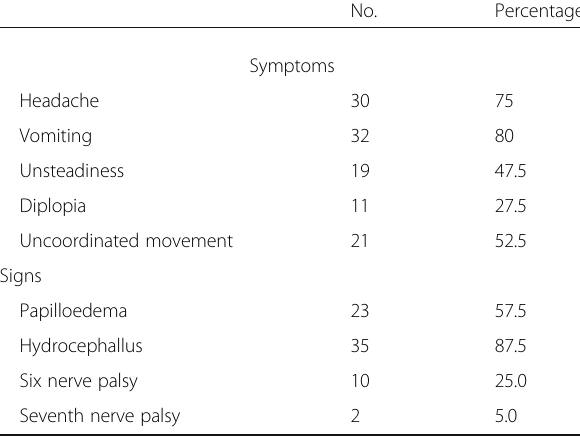
Table 2 Summary of patients ’ preoperative clinical status